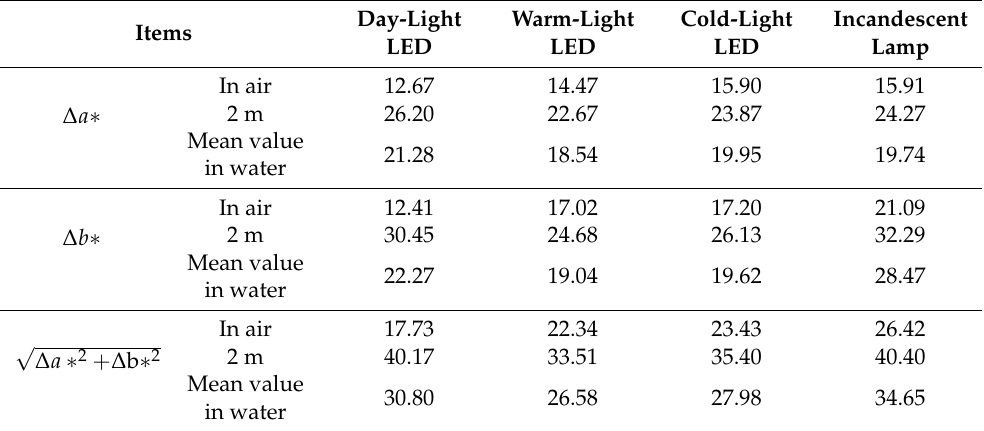
Table 1. The color deviation and nonlinear errors with different